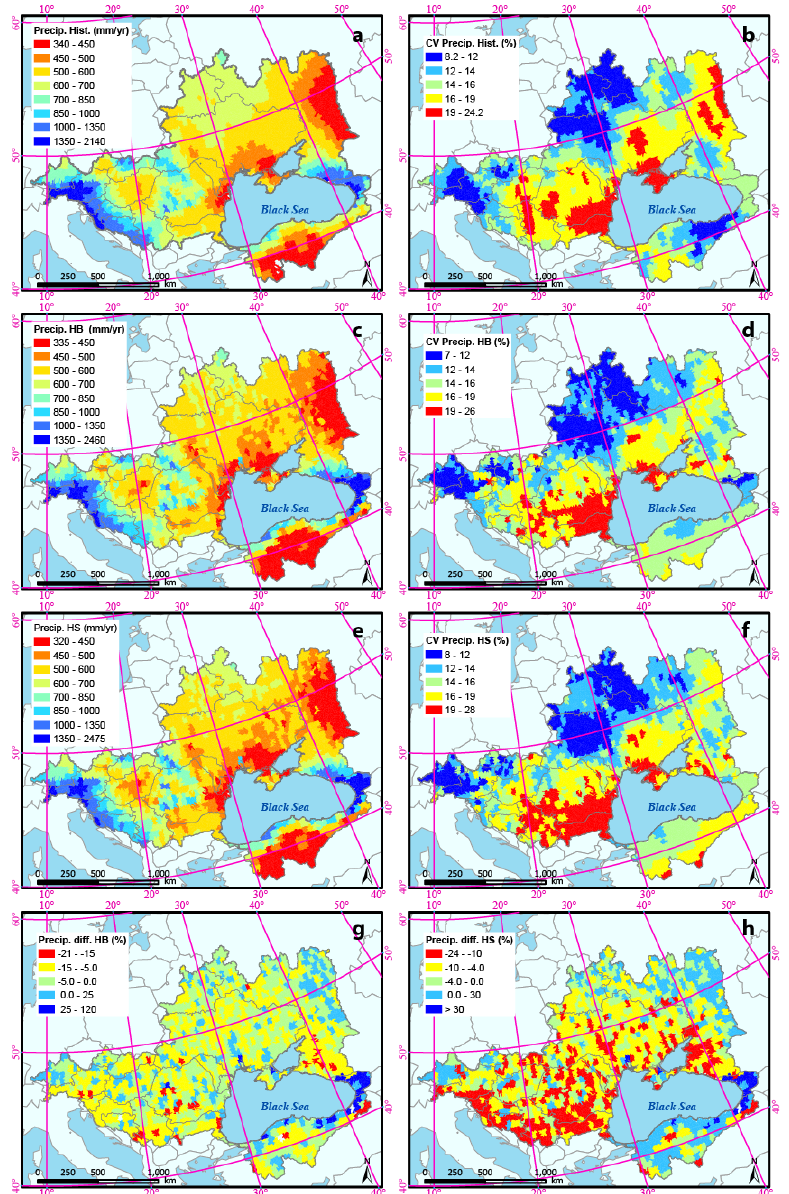
Figure 6. Precipitation distribution in the Black Sea Catchment: ( a ) average precipitation, historic